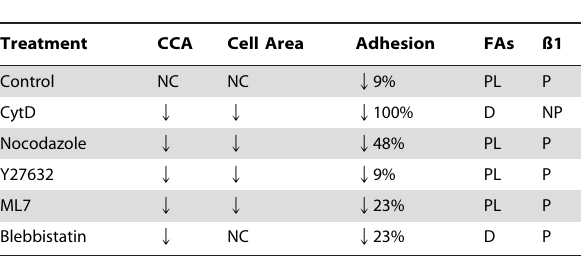
Table 2. Changes in CCA, Cell Area, Adhesion, FAs and ß1- integrin for control cells and cells exposed to various inhibitors for 60 min ( Q = decrease, NC=no change from the control, D =diffuse, PL =point-like, NP=not present and P=present).